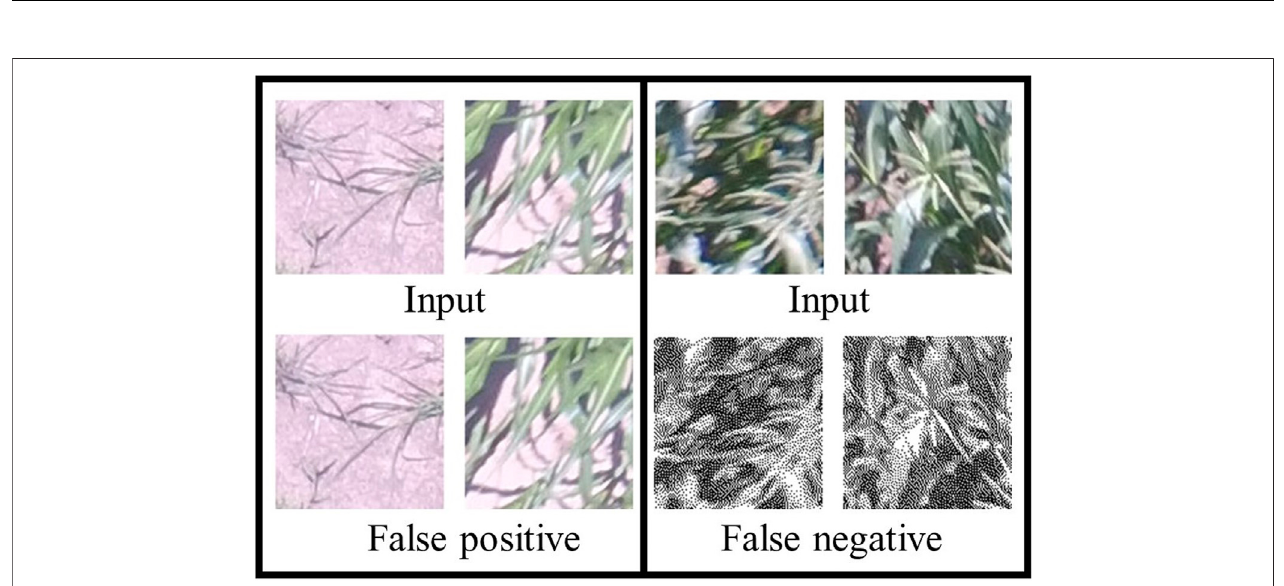
FIGURE 8 | [Best viewed in color] Examples of false positives and false negatives of the TD-CNN model.